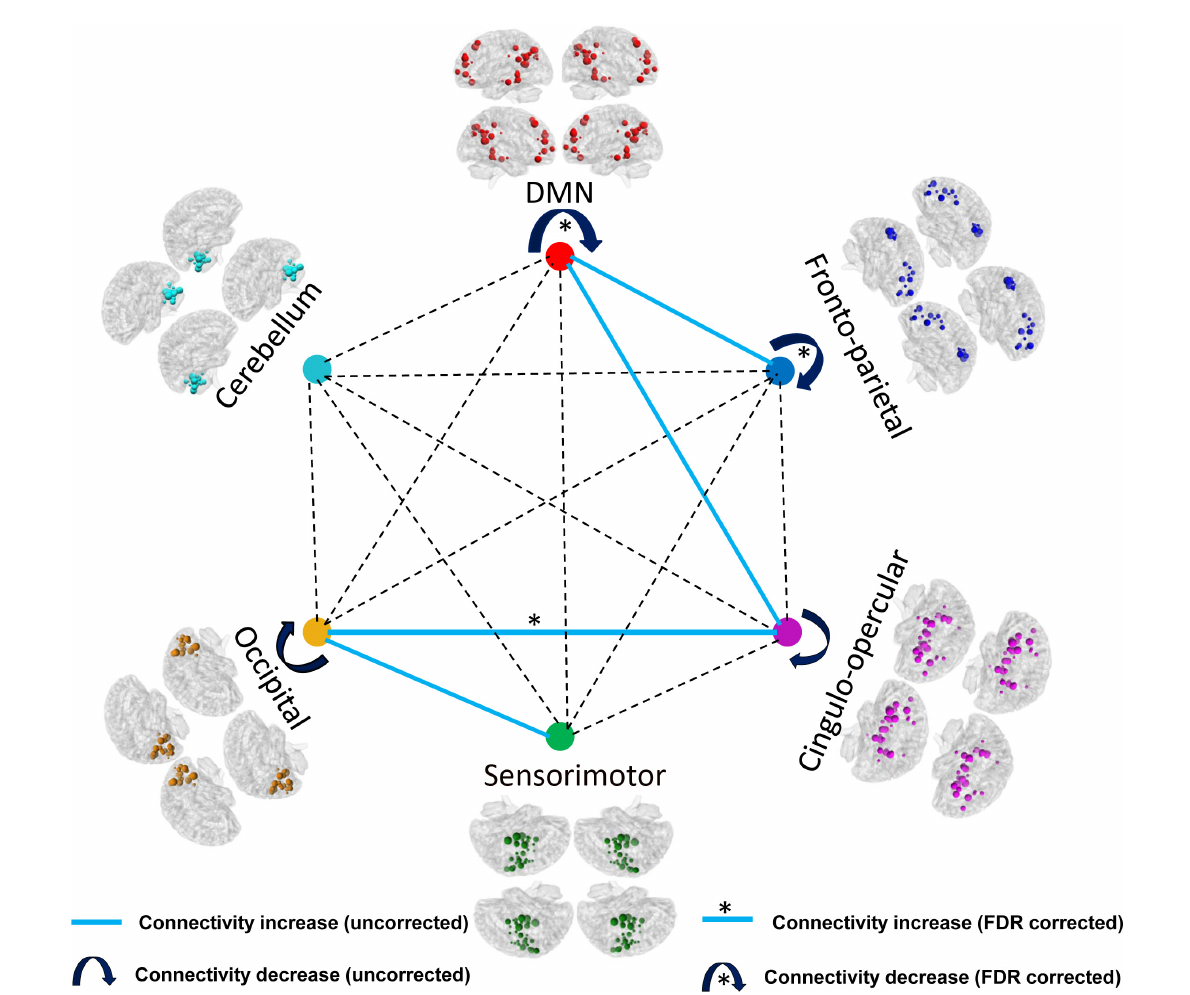
FIGURE3 Comparison results of the AUC of the averaged functional connectivity strength within and between the modules ( p < 0.05, FDR corrected). ∗ The connectivity can withstand the FDR